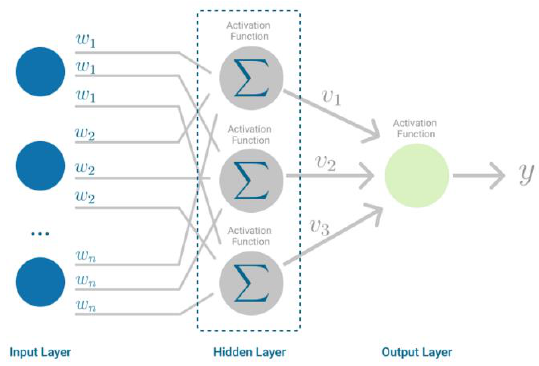
Figure 4. Multilayer Perceptron.